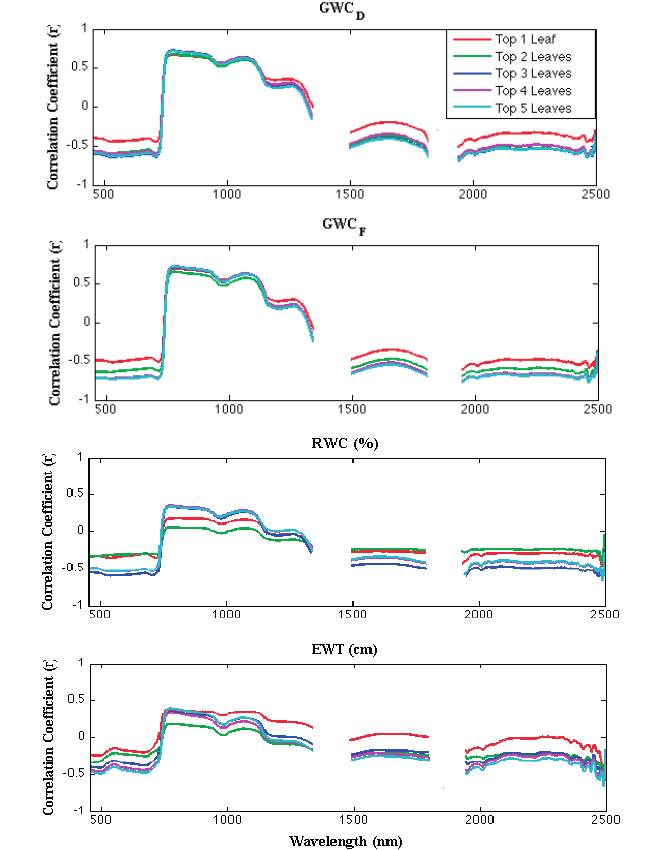
Figure 6. Correlation between canopy reflectance at all wavelengths and GWC D , GWC F , RWC, and EWT for the cumulative leaf number. Top one leaf corresponds to leaf No. 5, and top five leaves correspond to the leaf No.5 to leaf No.1. The significant correlation ( p < 0.001) was indicated by r greater than 0.52 or less than − 0.52 (33